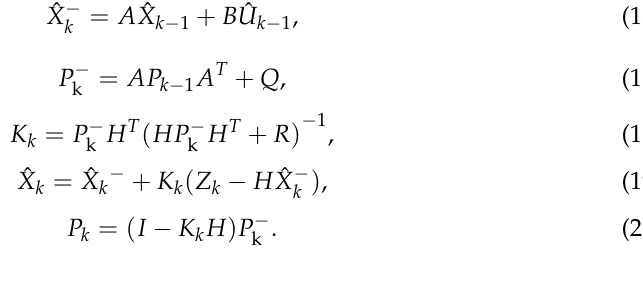
Table 2. Explanation of Symbols (16)–(20). Symbol